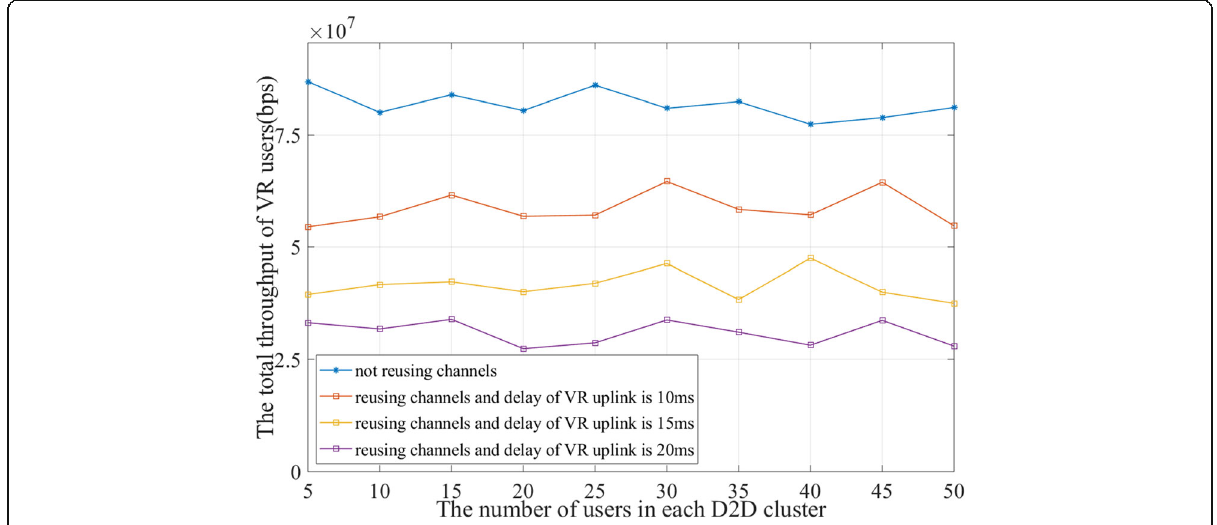
Fig. 5 The impact of the number of users in the D2D clusters on the total throughput of VR users